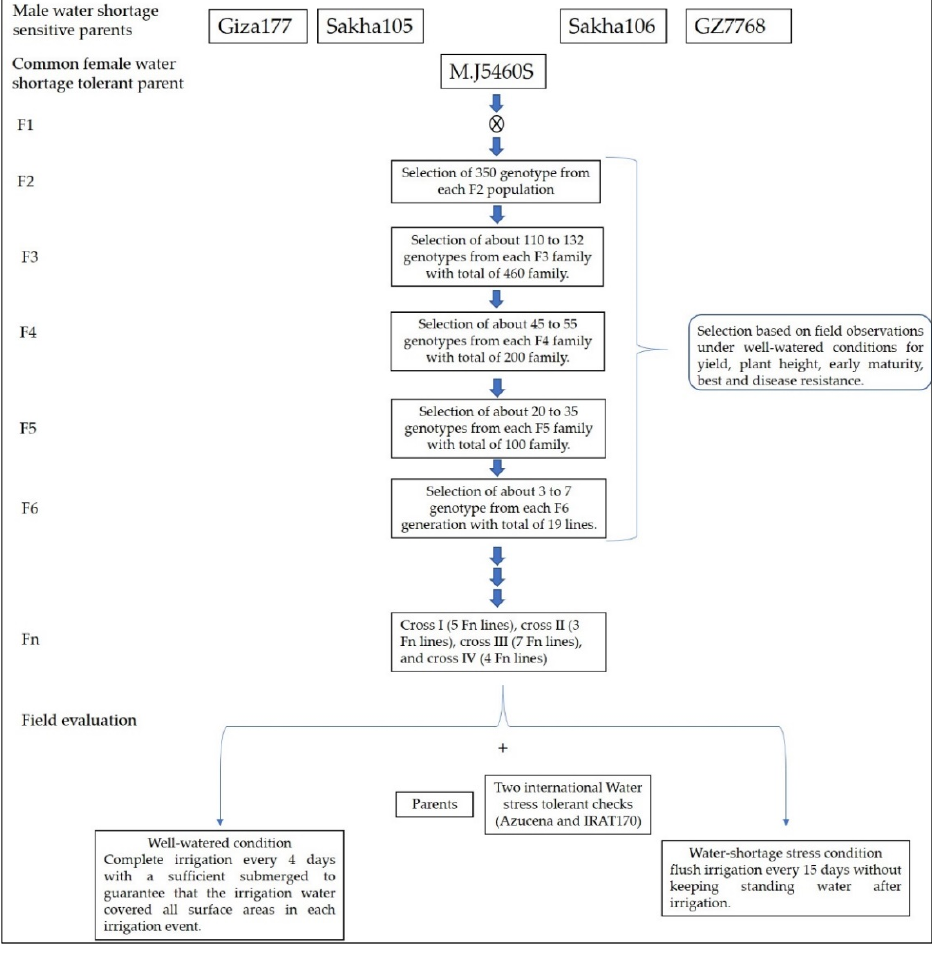
Figure 2. Description of the pedigree breeding scheme by which the new lines were developed and screened under well-watered and water shortage stress conditions.